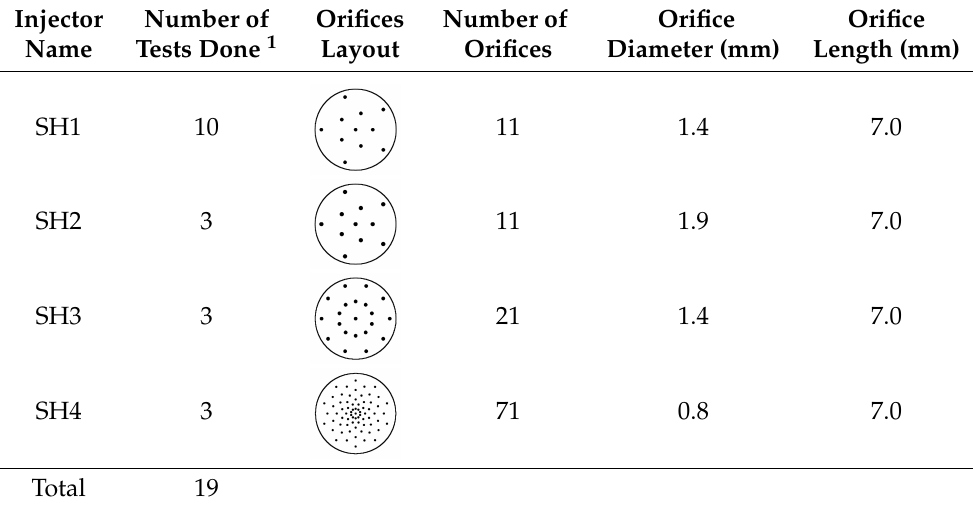
Table 1. Properties of the 4 types of SH injectors [29] used during the 19